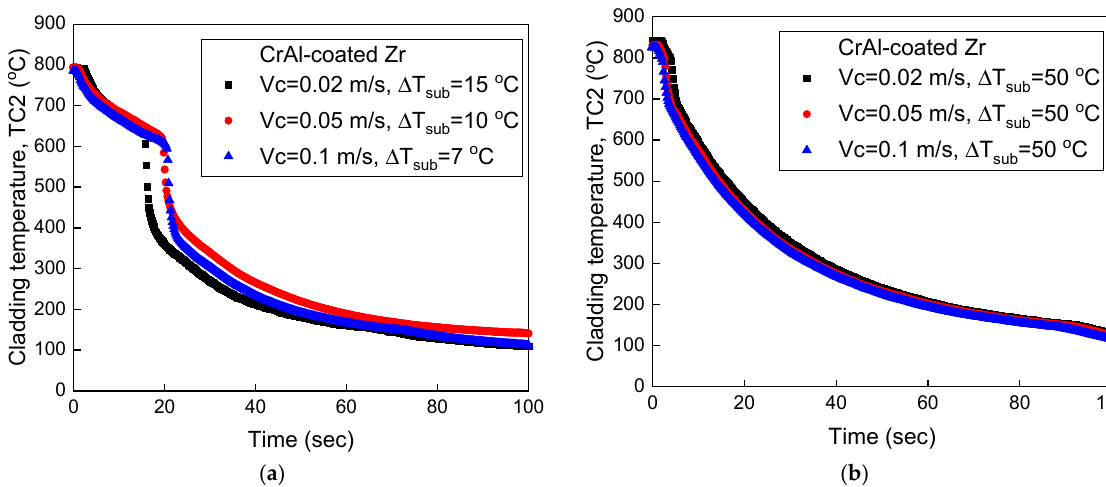
Figure 13. Effect of reflood velocity for the CrAl-coated Zr quenching at Tw = 800 °C; ( a ) low subcooling; ( b ) high subcooling.